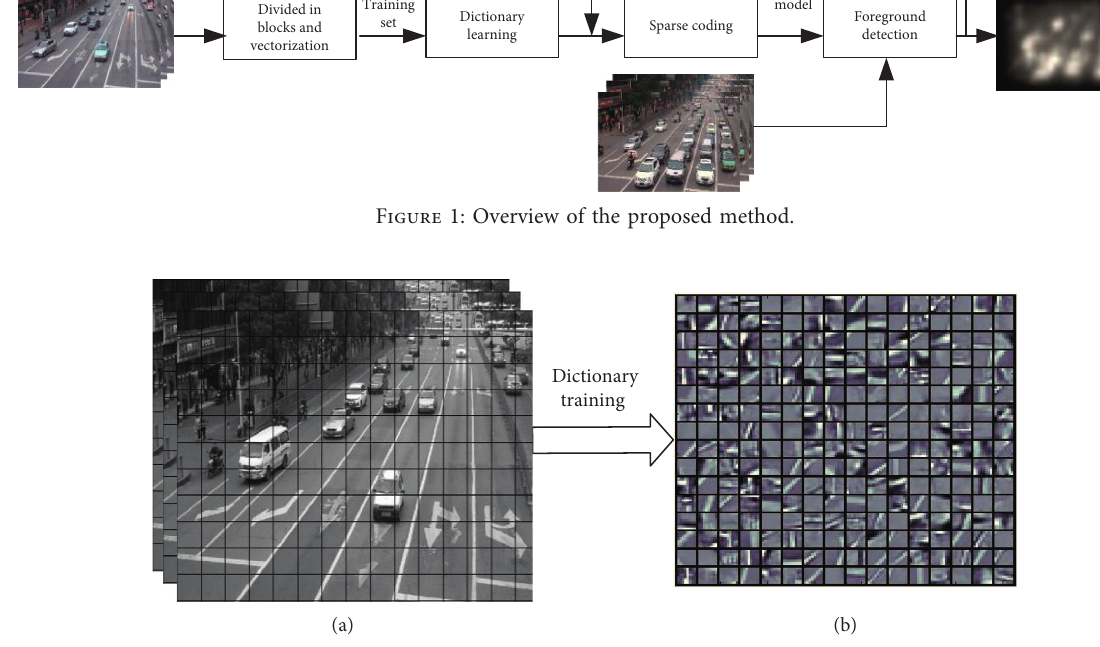
Figure 2: Initial background dictionary training. (a) Training set. (b) Training dictionary.